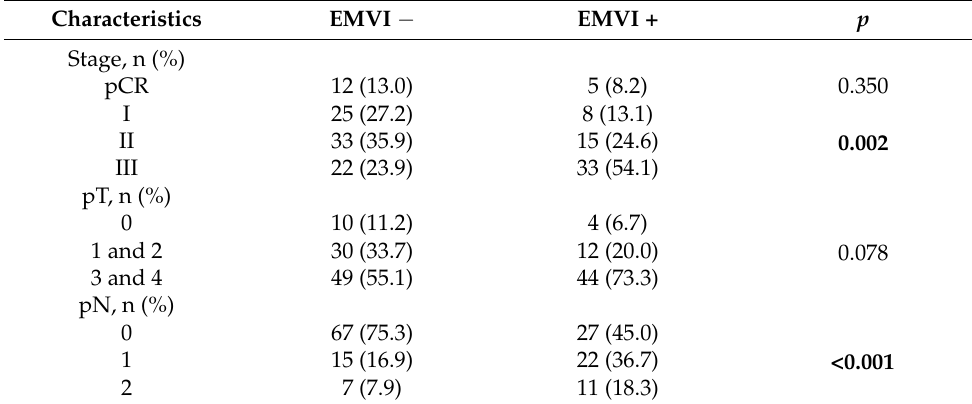
Table 4. Correlations between EMVI and pathological staging.